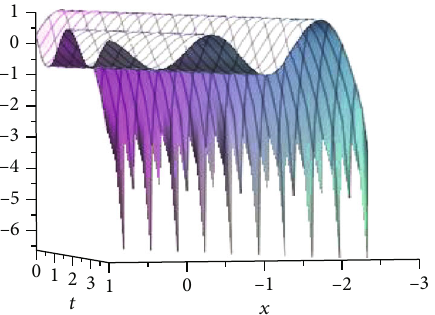
Figure 7: 3D plot of solution (34) of PDE